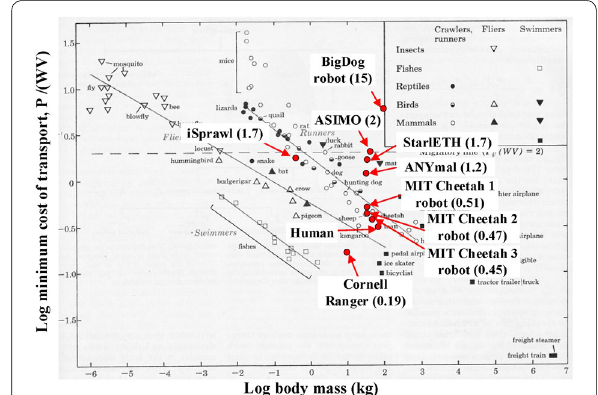
Figure 21 Plot of Cost of Transport vs body weight of animals and selected robots [10,